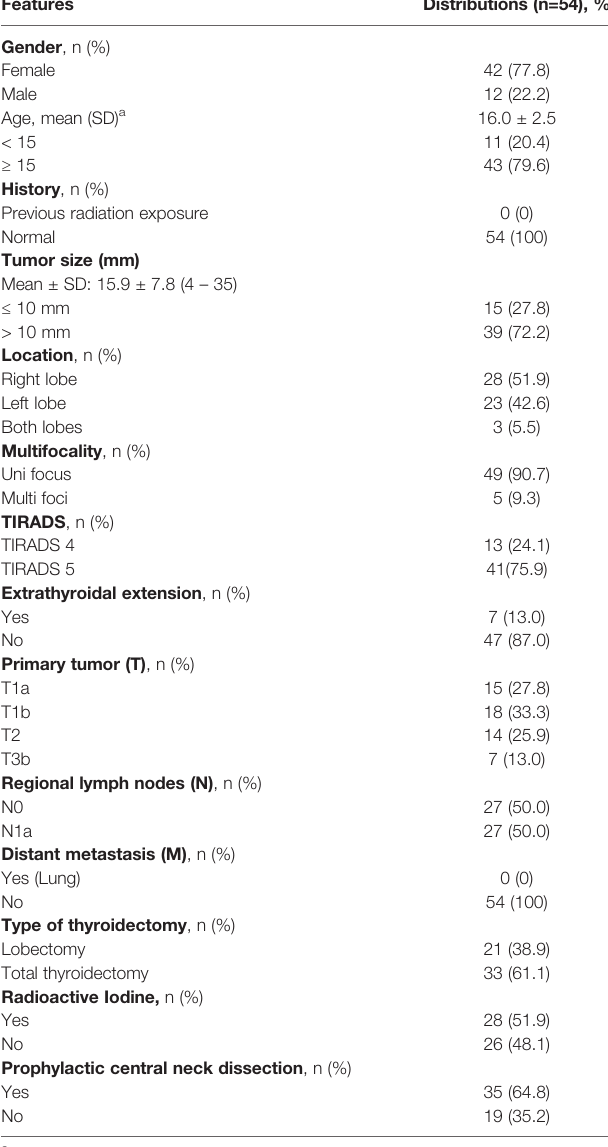
TABLE 1 | Clinicopathological features of cN0 papillary thyroid cancer in children.